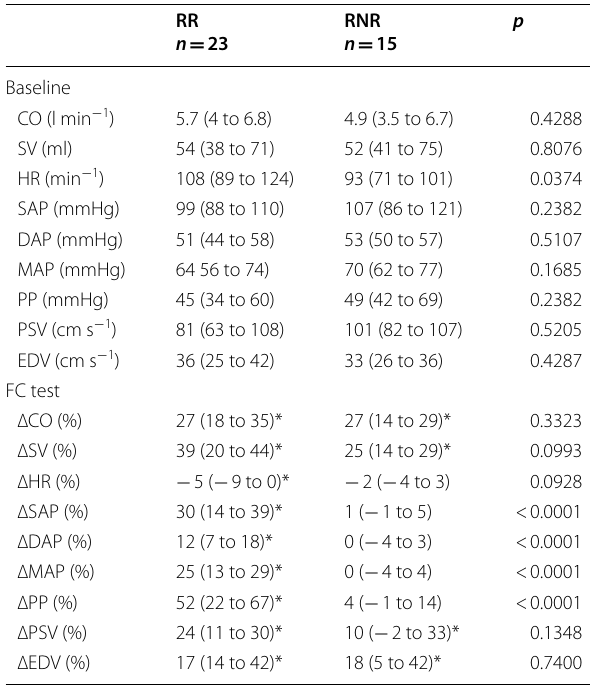
Table 3 Systemic and cerebral hemodynamics in patients responders–responders (RR) versus responders–non- responders (RnR) in the sepsis